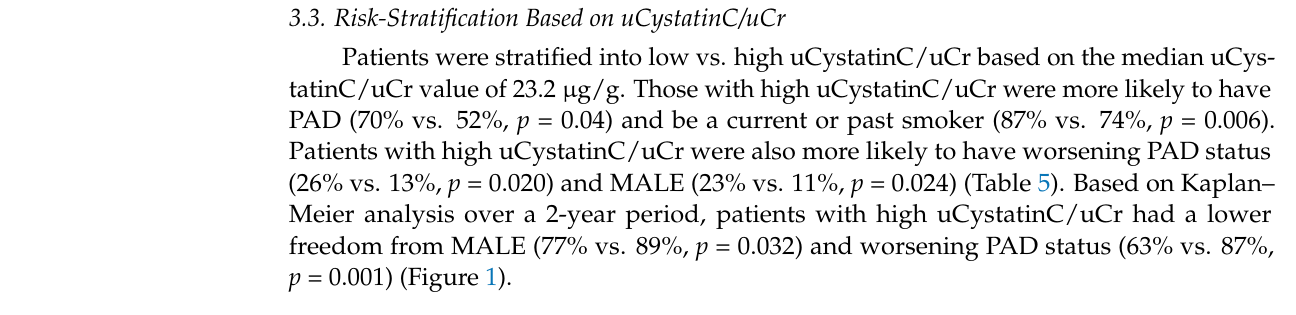
Table 5. Baseline demographic and clinical characteristics of patients with low and high uCystatinC/uCr. Low